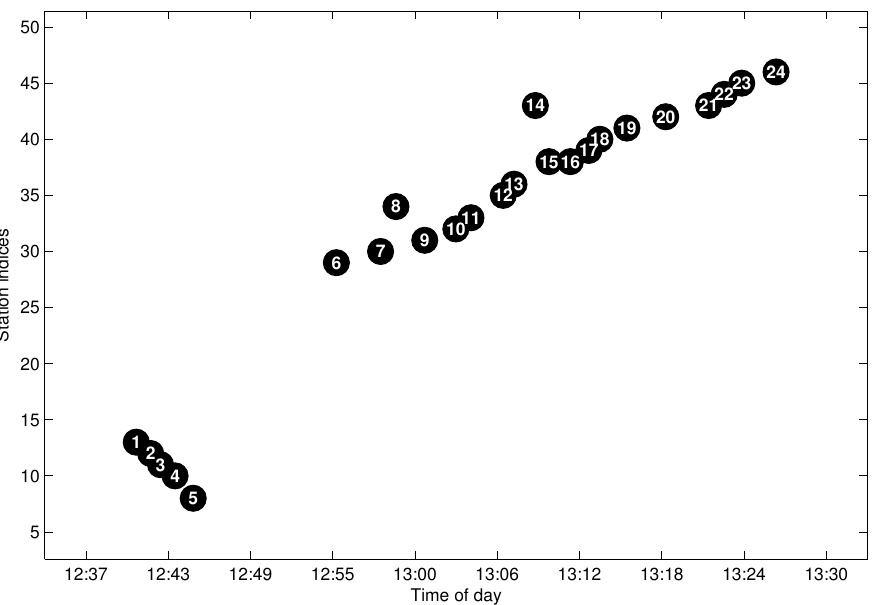
Figure 13. The aggregated trajectory fragment with noisy data.